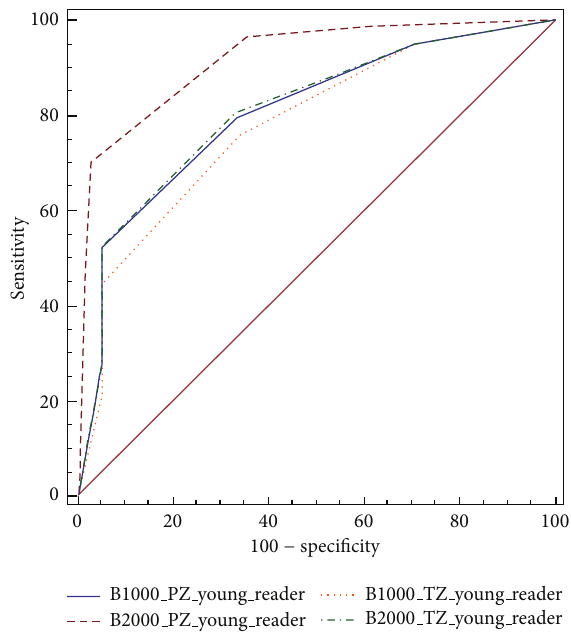
Figure 6: ROC curves for prostate cancer detection in the PZ (yellow and green lines) and TZ (blue and red lines) using ADC maps at 𝑏 -values of 0–1000 s/mm 2 and 0–2000 s/mm 2